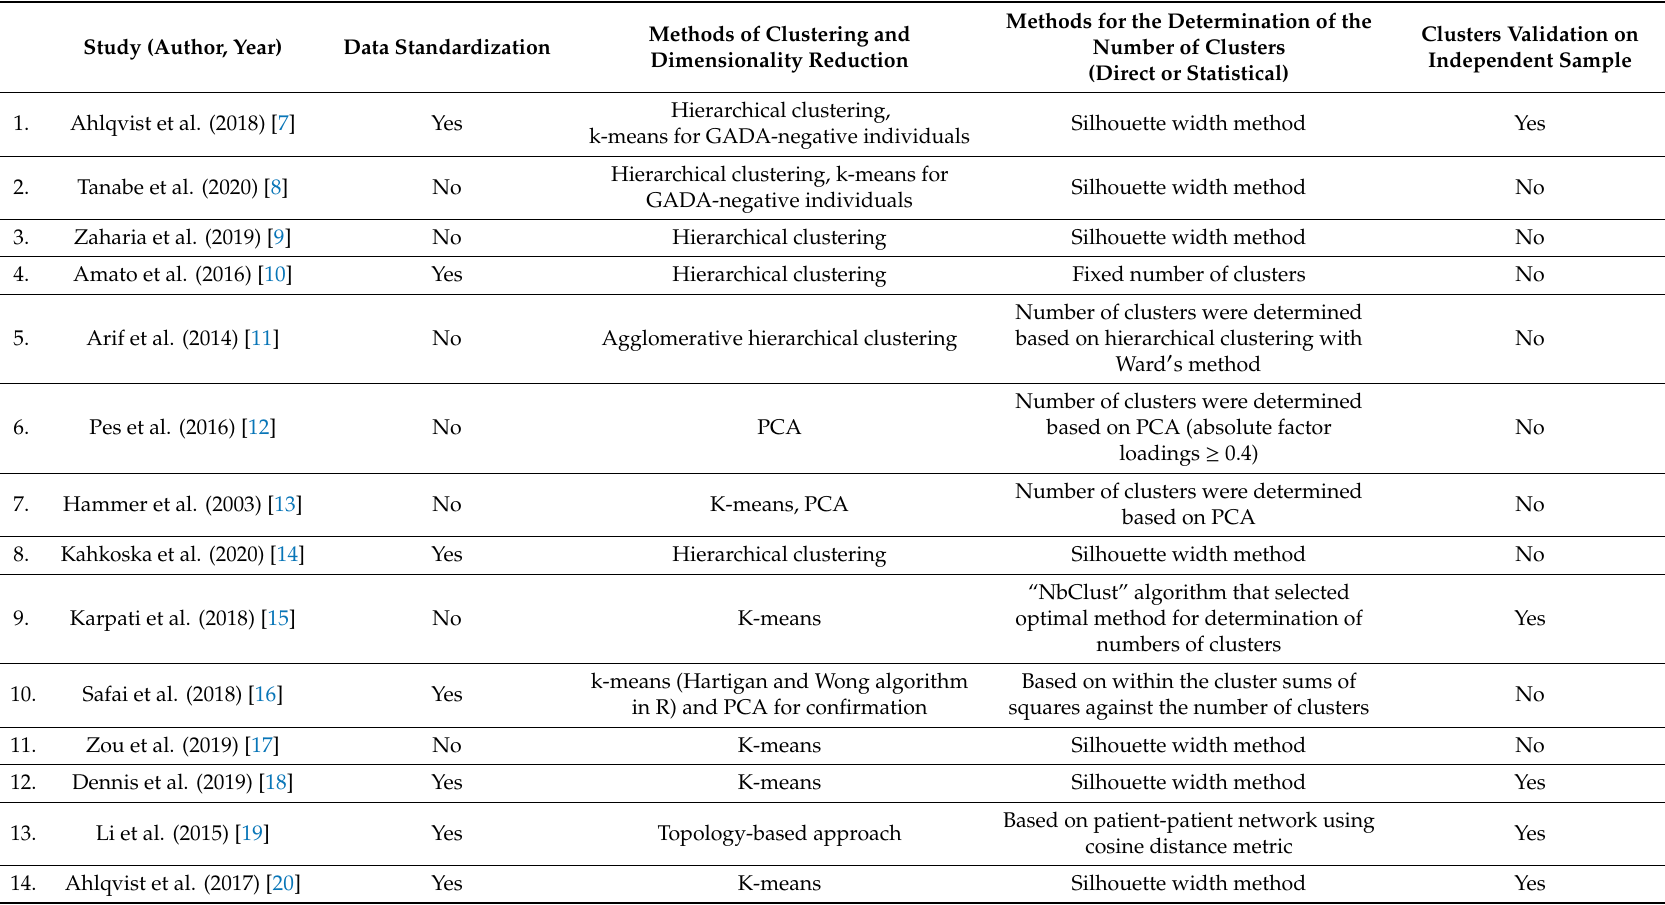
Table A2. Assessment of CA methodology in the selected